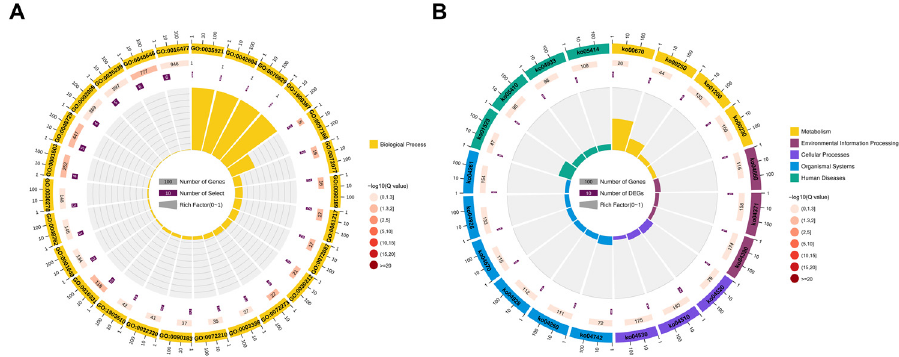
Figure 4. Enrichment analysis of cis-target genes of DE lncRNAs. ( A ) The top 26 GO terms of cis- target genes. ( B ) The top 20 KEGG pathways of cis-target genes. There are four circles from outside to inside. The first circle is the classification of GO or KEGG enrichment terms. Different colors represent different categories. The second circle shows the total number of foreground genes. The third circle represents the Q value and the number of background genes in the category. The fourth circle is the Rich Factor value of each category (the number of foreground genes in the category divided by the number of background genes). Each grid of the background auxiliary line represents 0.1.